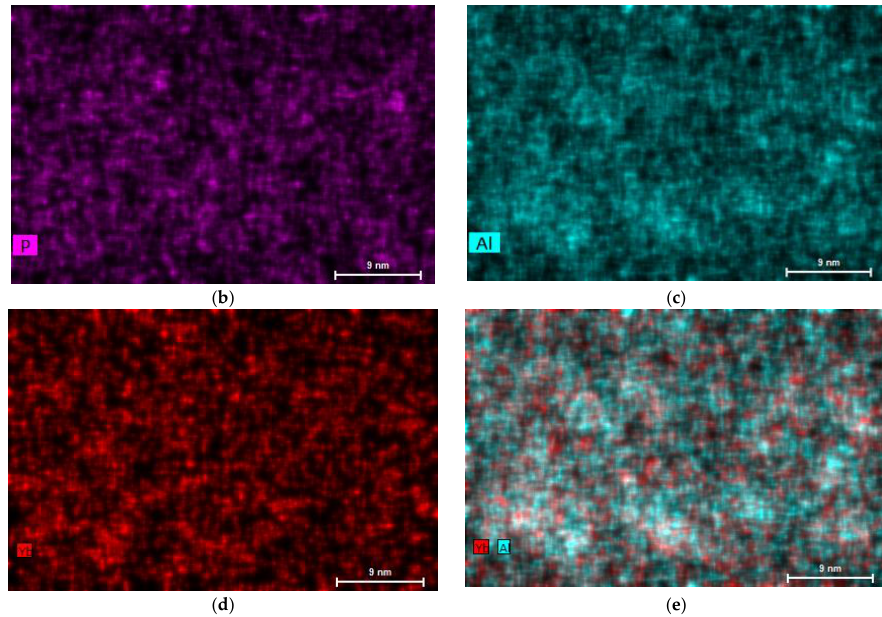
Figure 10. ( a ) HAADF-STEM micrograph; and ( b – d ) elemental mapping acquired at ultra-high magnification from a fiber core [8]. ( e ): Al and Yb chemical mapping.